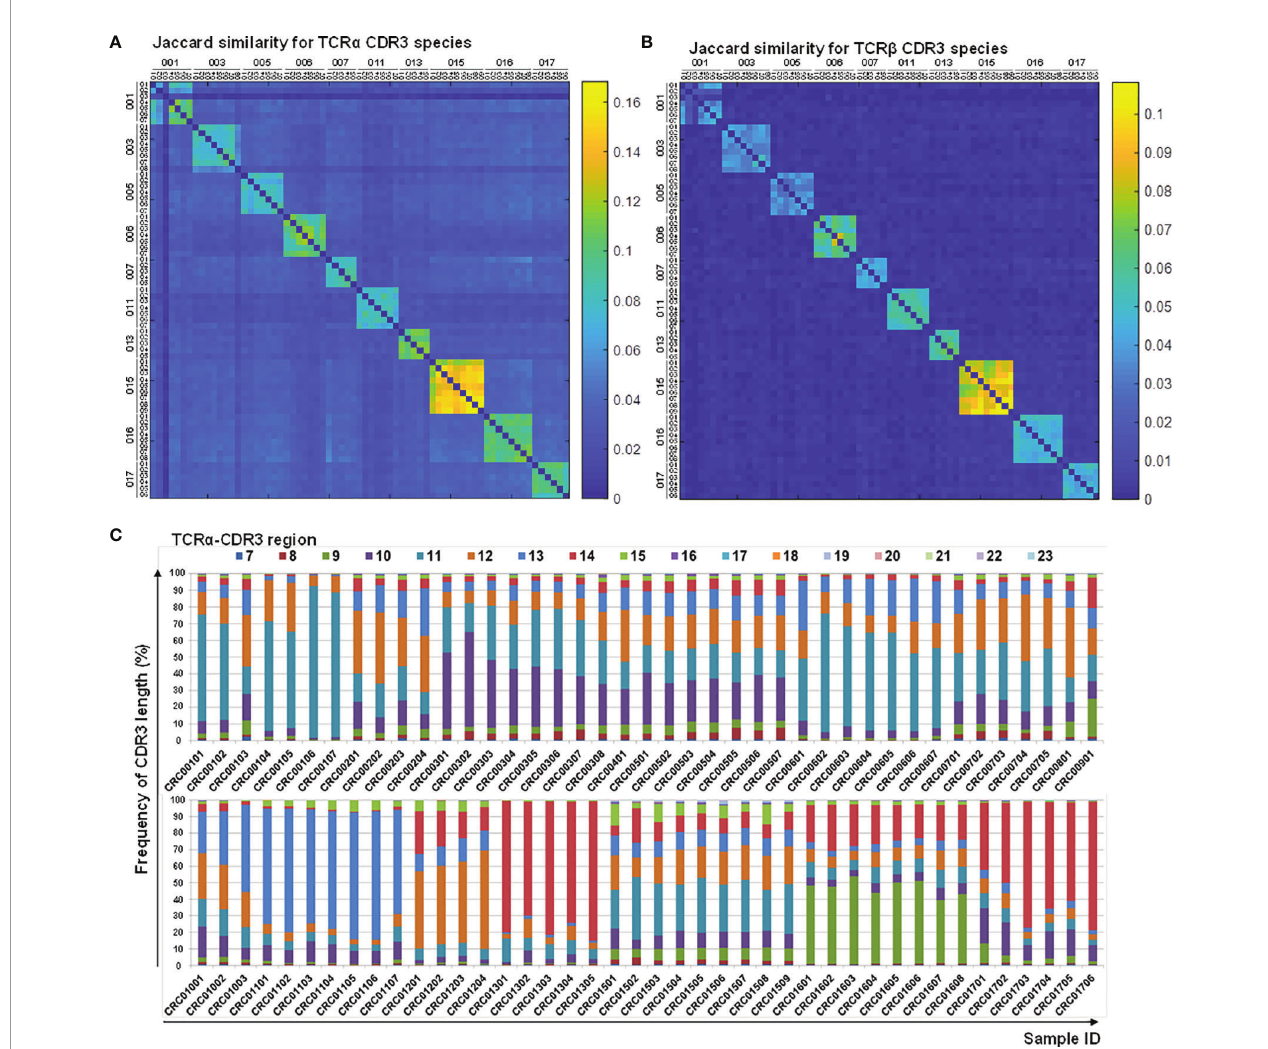
FIGURE 6 | Characteristics of CDR3 sequences and length distribution before and after therapy. CDR3 sequences from the TCR a (A) and TCR b (B) repertoires of follow-up CRC patients (CRC-pre and paired CRC-post) were subjected to Jaccard coef fi cient analyses to illustrate the similarity between samples, and the coef fi cient between any two given samples was colored coded and illustrated using a heat map. The coef fi cient scale is shown. (C) CDR3-encoded amino acid length distributions of the TCR a repertoires are presented as color-coded percentage bar graphs. The sample ID is the x-axis, and the peptide length frequency is the